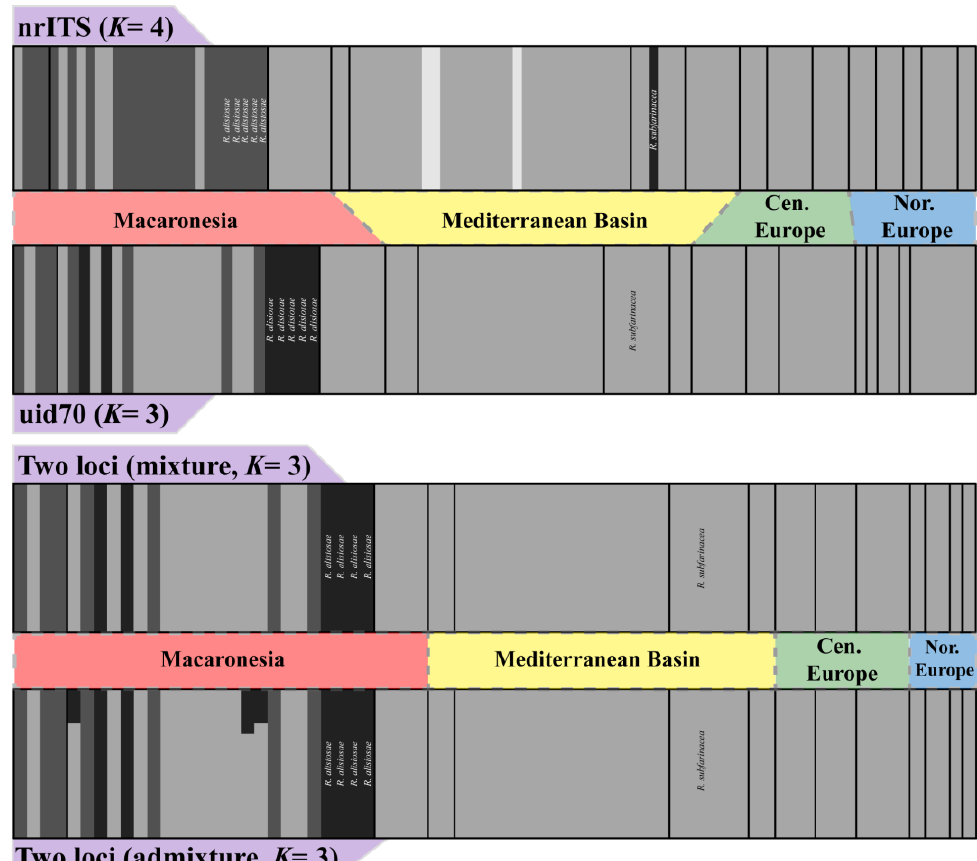
Figure 3. Single-locus and two-locus mixture and admixture results from Bayesian clustering analyses conducted with BAPS using nrITS and uid70 SNP data from Ramalina farinacea and closely related species; note that the nrITS dataset consisted only of newly generated data in the present study (i.e., available GenBank nrITS sequences were excluded).